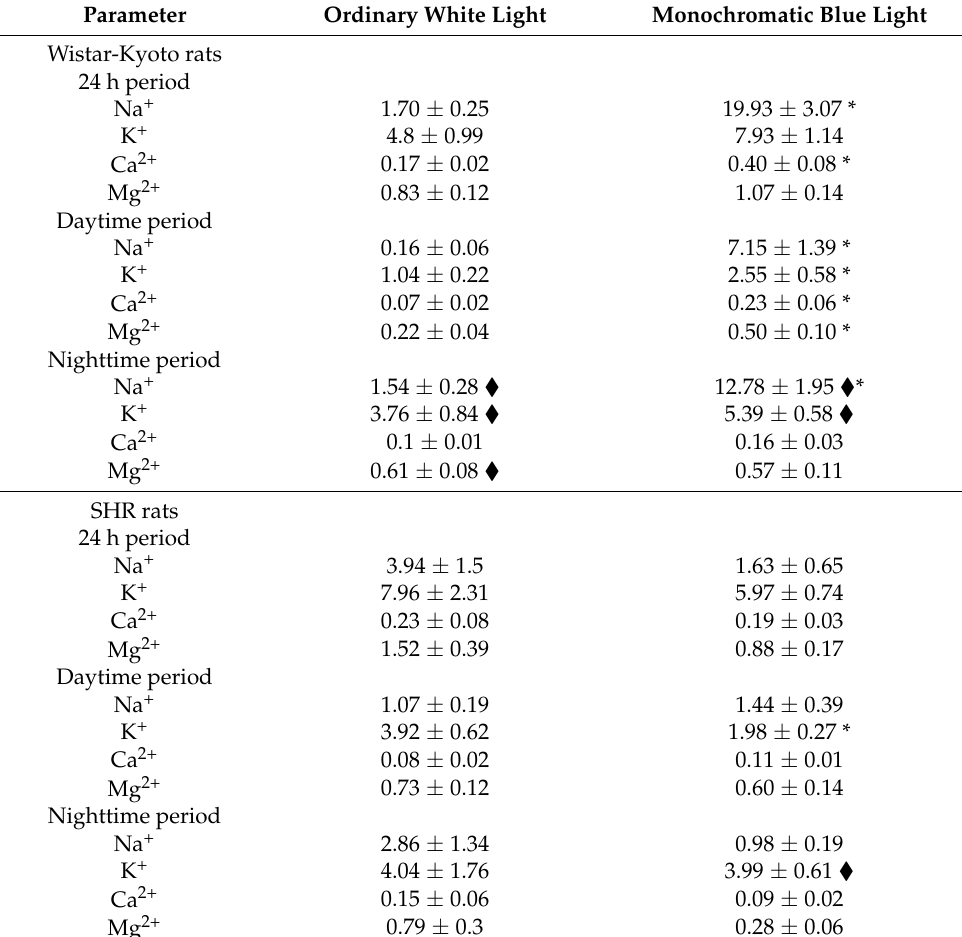
Table 1. Indicators of electrolyte excretion in Wistar–Kyoto and SHR rats under the standard light pattern (12 h:12 h) with ordinary white and monochromatic blue light (mmol, M ±